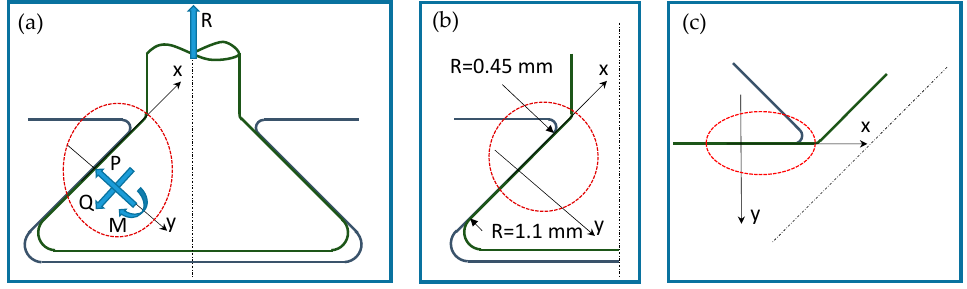
Figure 3. Contact geometry: ( a ) blade root; ( b ) contact surfaces of one side; ( c ) rotated half contact surfaces of one side.